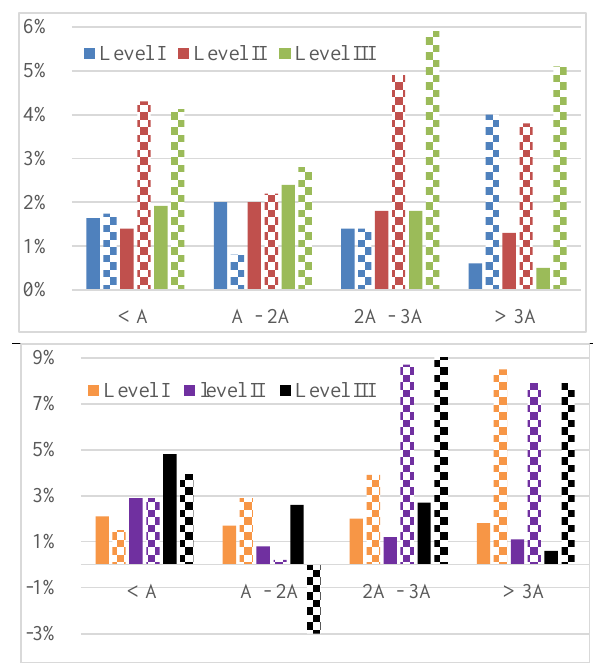
Figure 4: Differences of OA (top) and mF1 (bottom) between different network variants in Hameln. Solid bars: differences between LuNet-lite-JO-ENS and LuNet- lite-JO-T ; checkered bars: differences between LuNet- lite-JO-ENS and LuNet-lite-JO-MS.